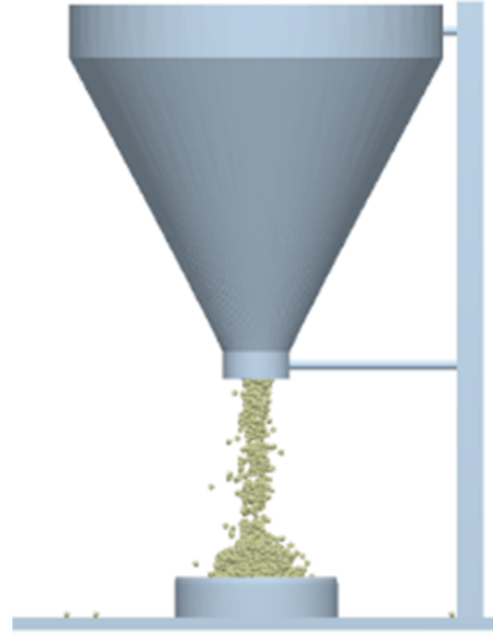
Figure 7. The simulation process of the rest angle.